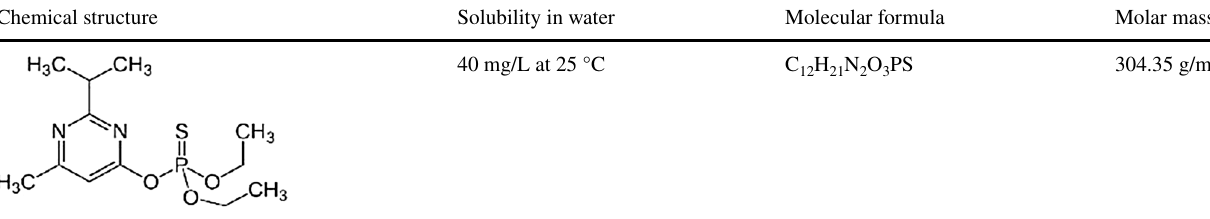
Table 1 Physicochemical characteristics of DZN (Ouznadji et al. 2016; Samadi et al. 2010) Chemical